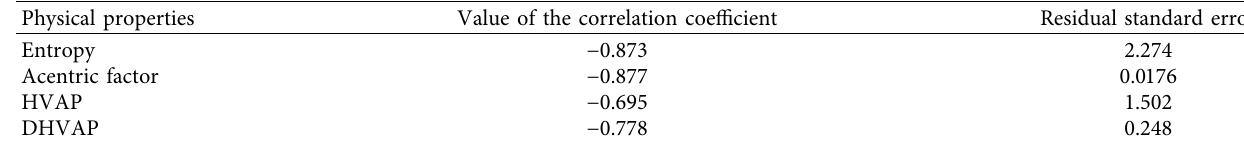
Table 4: Parameters of regression models for the NGH index.